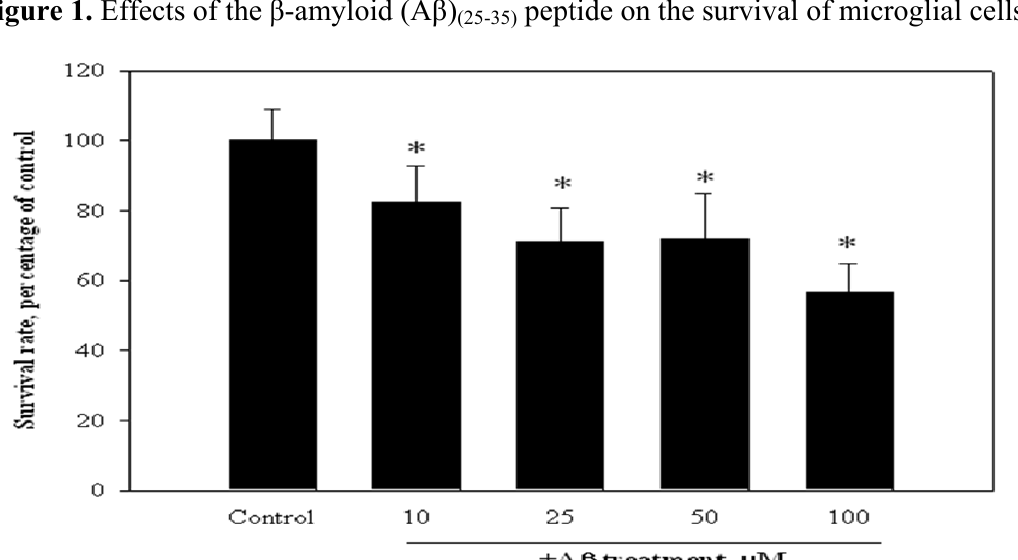
Figure 1. Effects of the β -amyloid (A β )